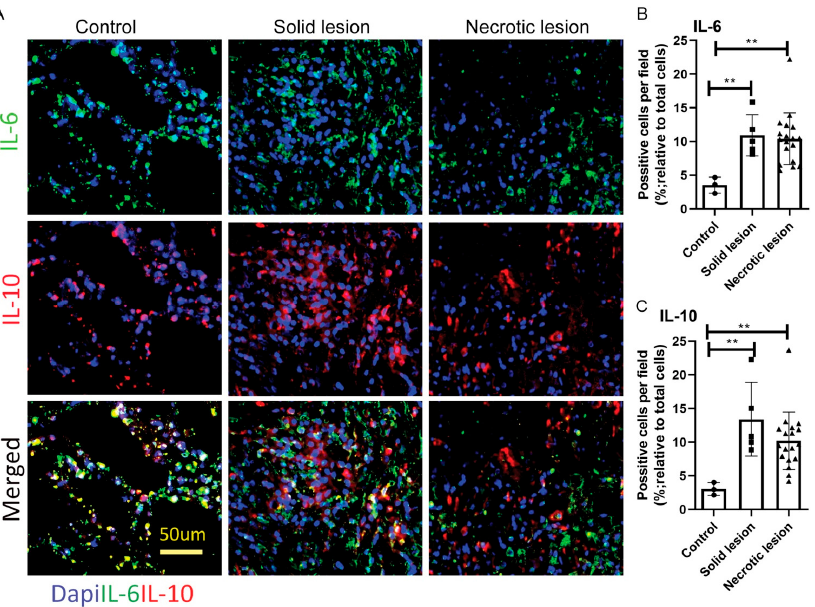
Figure 4. Multiplex immunostaining and imaging of IL-6 and IL-10 expressing cells in human granulomas. ( A ) Graphical representation of the expression of IL-6 (green spots) and IL-10 (red spots) as well as their co-localization (brown spots) in lung tissues corresponding to control, solid/non-necrotic and necrotic granulomas determined by immunofluorescence. Host cell nucleus is stained blue with DAPI. Scale bar (50 microns) is common for all the images. ( B ) Cells positive for IL-6 relative to the total number of cells in the field in control, solid/non-necrotic granulomas and necrotic granulomas. ( C ) Cells positive for IL-10 relative to the total number of cells in the field in the control and solid/non-necrotic granulomas and necrotic granulomas. Data plotted in ( B , C ) are mean and standard error mean (SEM) of n = 3 (control); n = 5 (solid lesion) and n = 18 (necrotic lesion). Data were analyzed by One-way ANOVA with Tukey’s post-hoc correction for a multiple group comparison; ** p < 0.01.